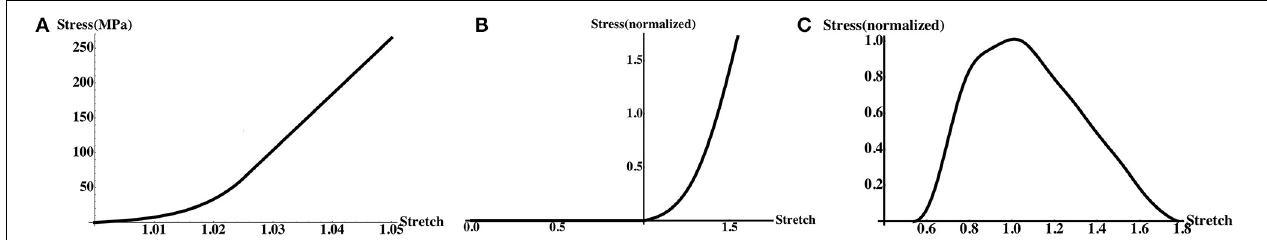
FIGURE 2 | Along-fiber stress-stretch curves used by the model. (A) Aponeurosis (Equation 11). (B) Passive muscle (Equation 13). (C) Active muscle (Equation